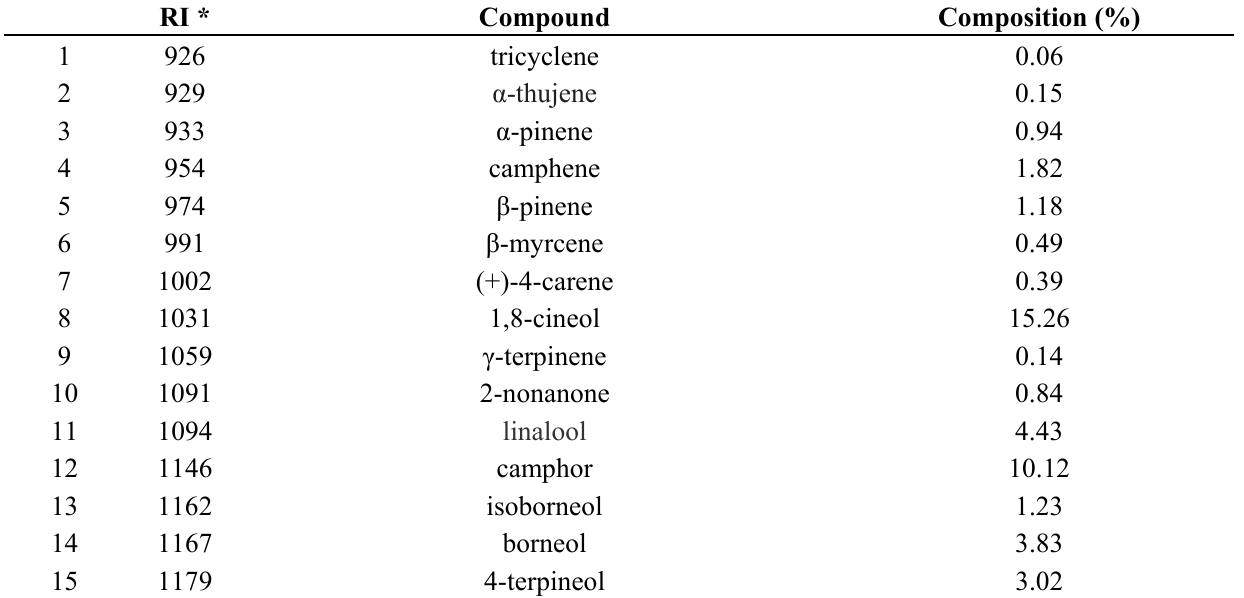
Table 1. Chemical constituents of the essential oil derived from Curcuma wenyujin